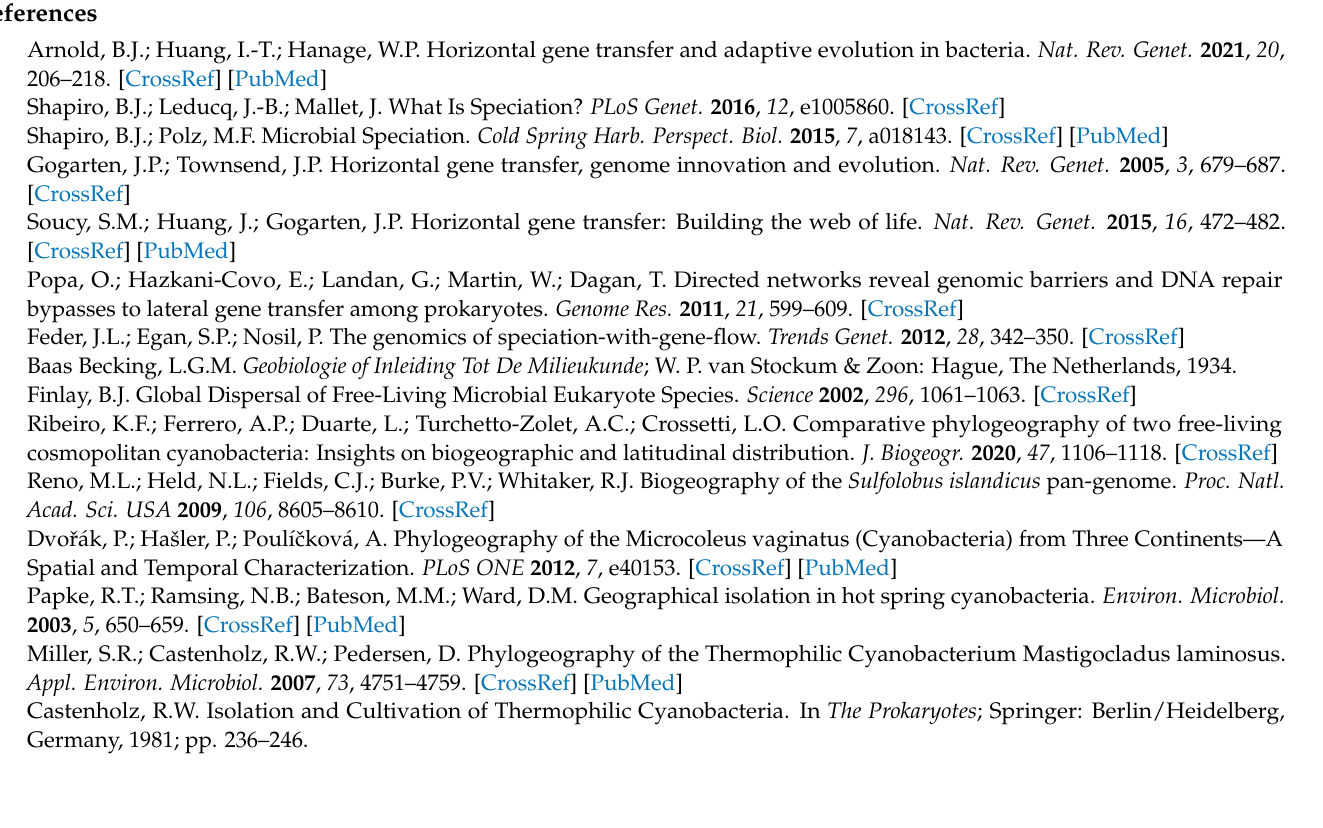
m9.figshare.14423195. Table S3: A table with a list of CRISPR repeats for each investigated strain. https://doi.org/10.6084/m9.figshare.19710835. Table S4: A list of investigated strains with assembly accession numbers in GenBank and their finishing level according to the GenBank